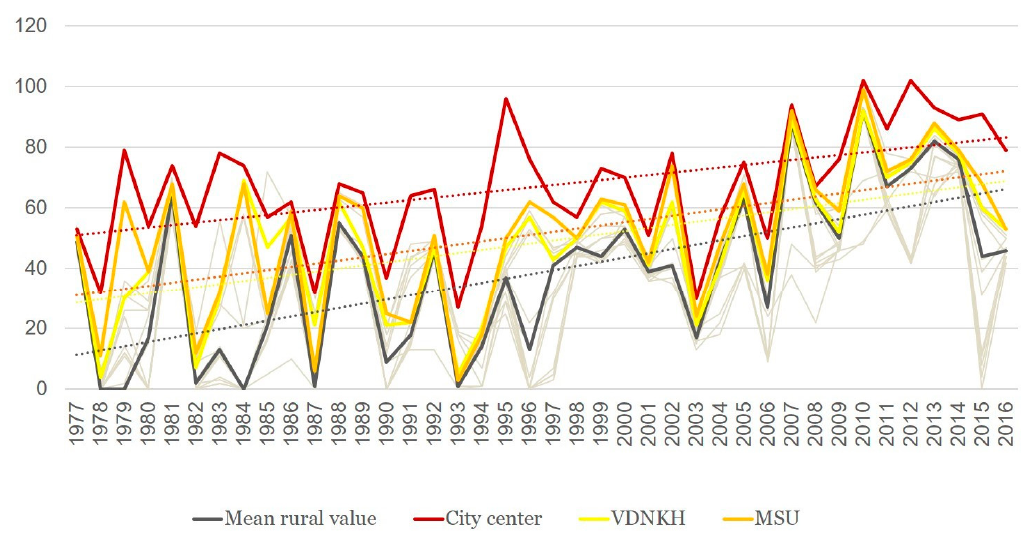
Figure 7. Change in the duration of season of effective infectivity (SEI) at urban and suburban stations, in comparison with the average background conditions in the Moscow region in 1977–2016 (dashed lines show linear trends, thin gray lines indicate the rest of the analyzed stations).